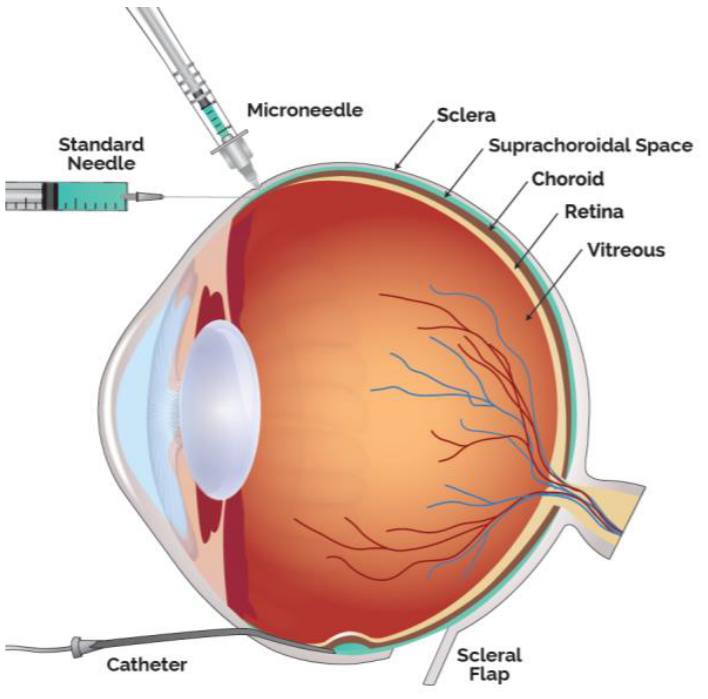
Figure 2. Modalities to Administer Therapeutic Agents into the Suprachoroidal Space (SCS).